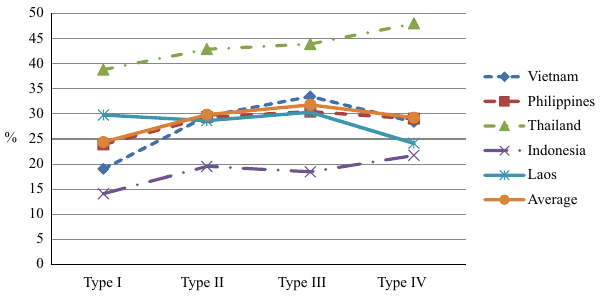
Figure 2. Product